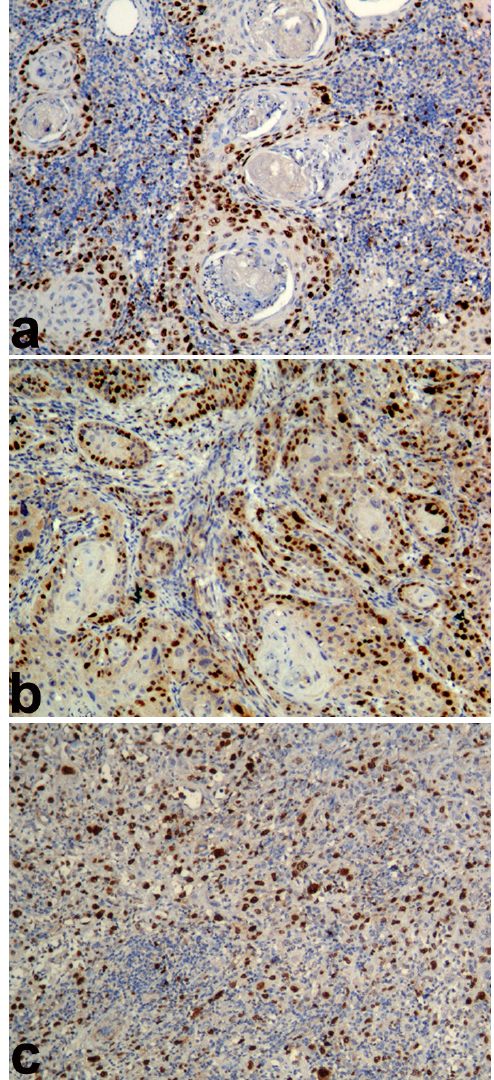
Figure 1- Photomicrograph showing Ki67 antigen expression (Ki67 labeling index) in a) Well differentiated squamous cell carcinoma, b) Moderately differentiated squamous cell carcinoma, c) Poorly Moderately differentiated squamous